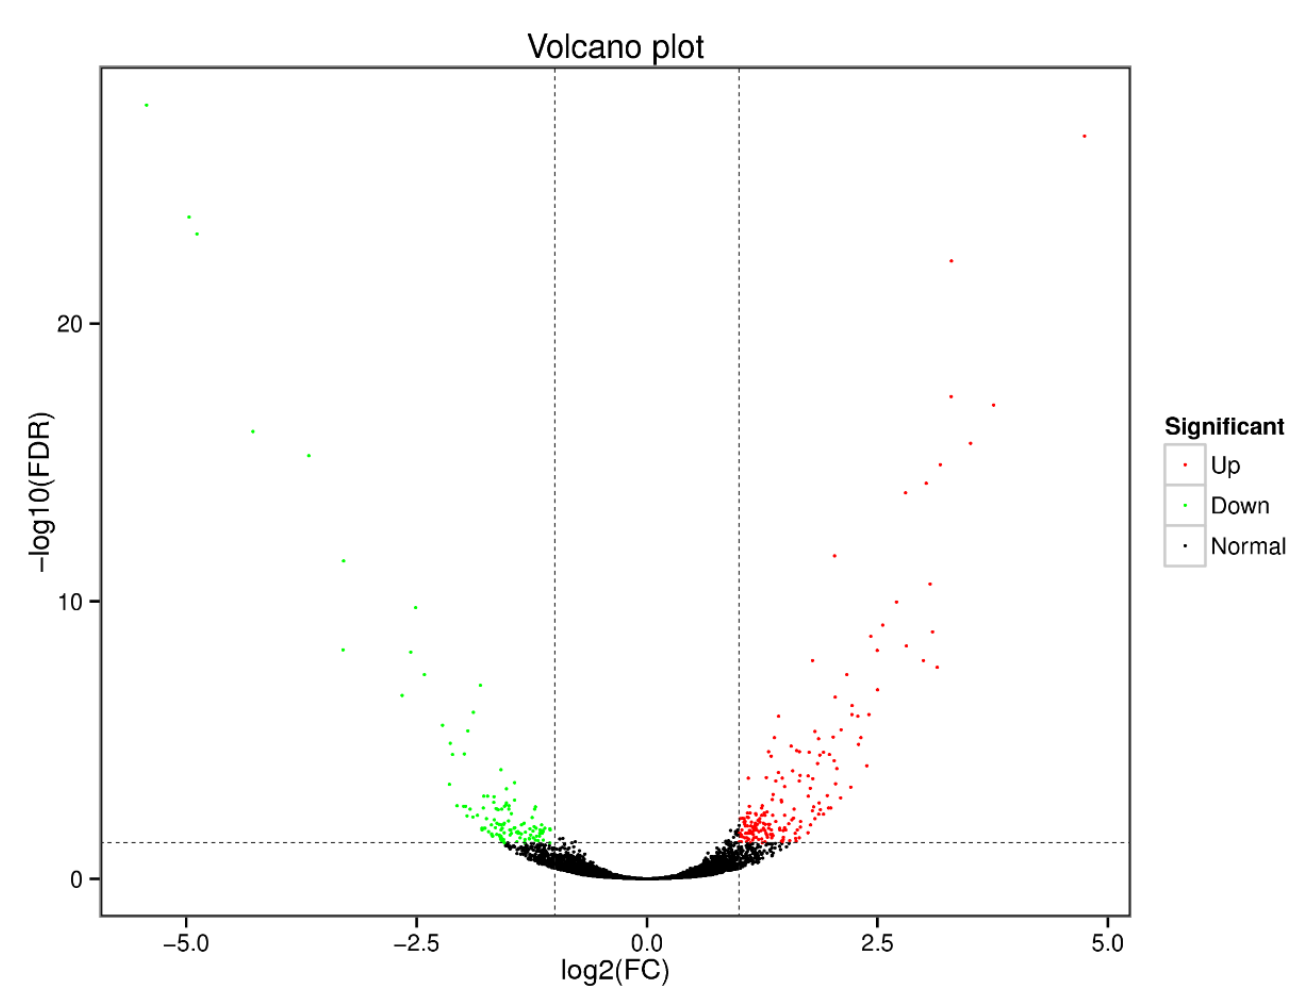
Figure 3. Volcano plot of differential gene expression in the zebrafish liver. Green dots represent down-regulated genes in the 1% Aurantiochytrium sp. extract group, red dots represent up-regulated genes, and black dots represent non-differentially expressed genes. Significance criteria were q < 0.05 and fold change ≥ 2.